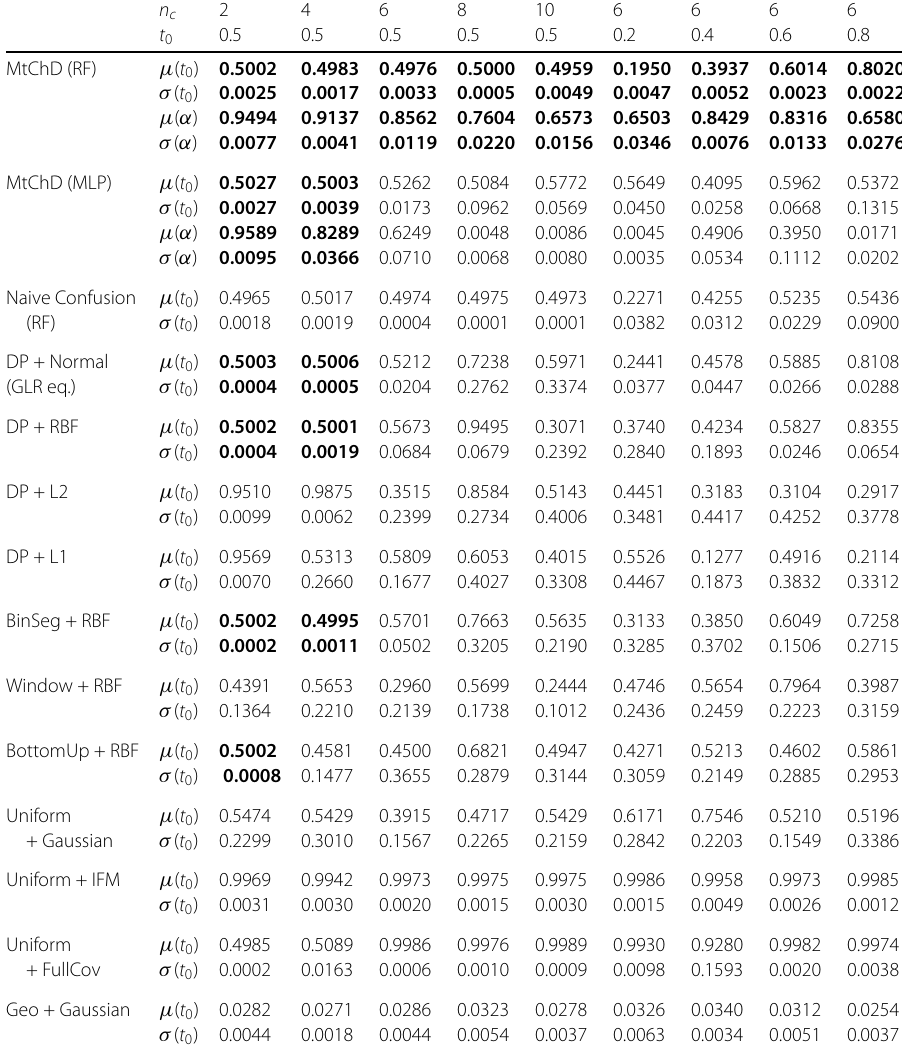
Table 1 A comprehensive comparison of the performance of the proposed method against two types of state-of-the-art methods: optimal segmentation and Bayesian change point detection on synthetic data. MtChD(RF) is our method with a random forest classifier; MtChD(MLP) is our method with a MLP classifier. DP + Normal (GLR eq.) is DP segmentation method used with normal loss function, which is equivalent to GLR test that assumes a multivariate normal distribution. Six combinations of optimal segmentation methods are listed. DP is dynamic programming segmentation algorithm, BinSeg is binary segmentation, Window is window-based change point detection, and BottomUp is Bottom-up segmentation. The cost functions used are RBF (RBF kernel), L1 ( L 1 loss function), and L2 ( L 2 loss function). The last four rows are for Bayesian change point detection with a uniform prior or Geo (geometric) prior. Gassusian stands for Gaussian likelihood function, IFM is the individual feature model [30], and FullCov is the full covariance model [30]. μ ( t 0 ) and σ ( t 0 ) are the mean value and standard deviation of inferred change point and μ ( α ) and σ ( α ) are the mean value and standard deviation of inferred α . Bold values indicate change points that are closest to the correct value